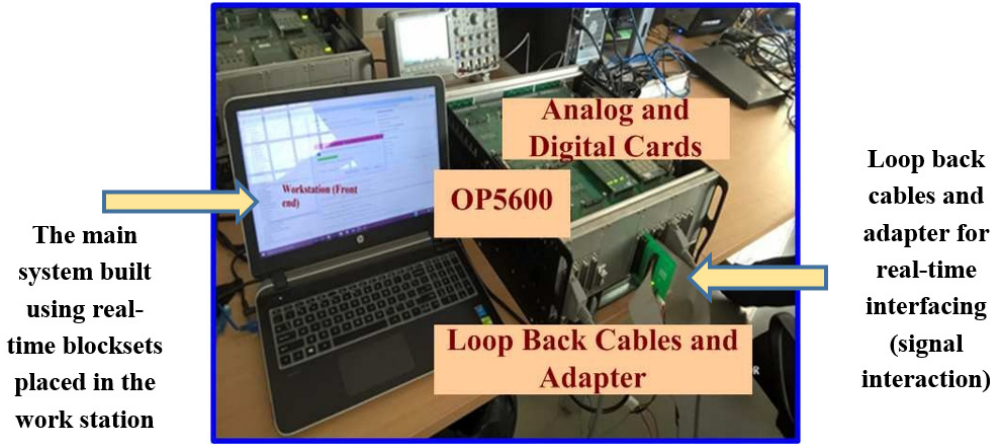
Figure 4. Representation of the real ‐ time processor ‐ in ‐ loop test bench for a multi core target OP5600.